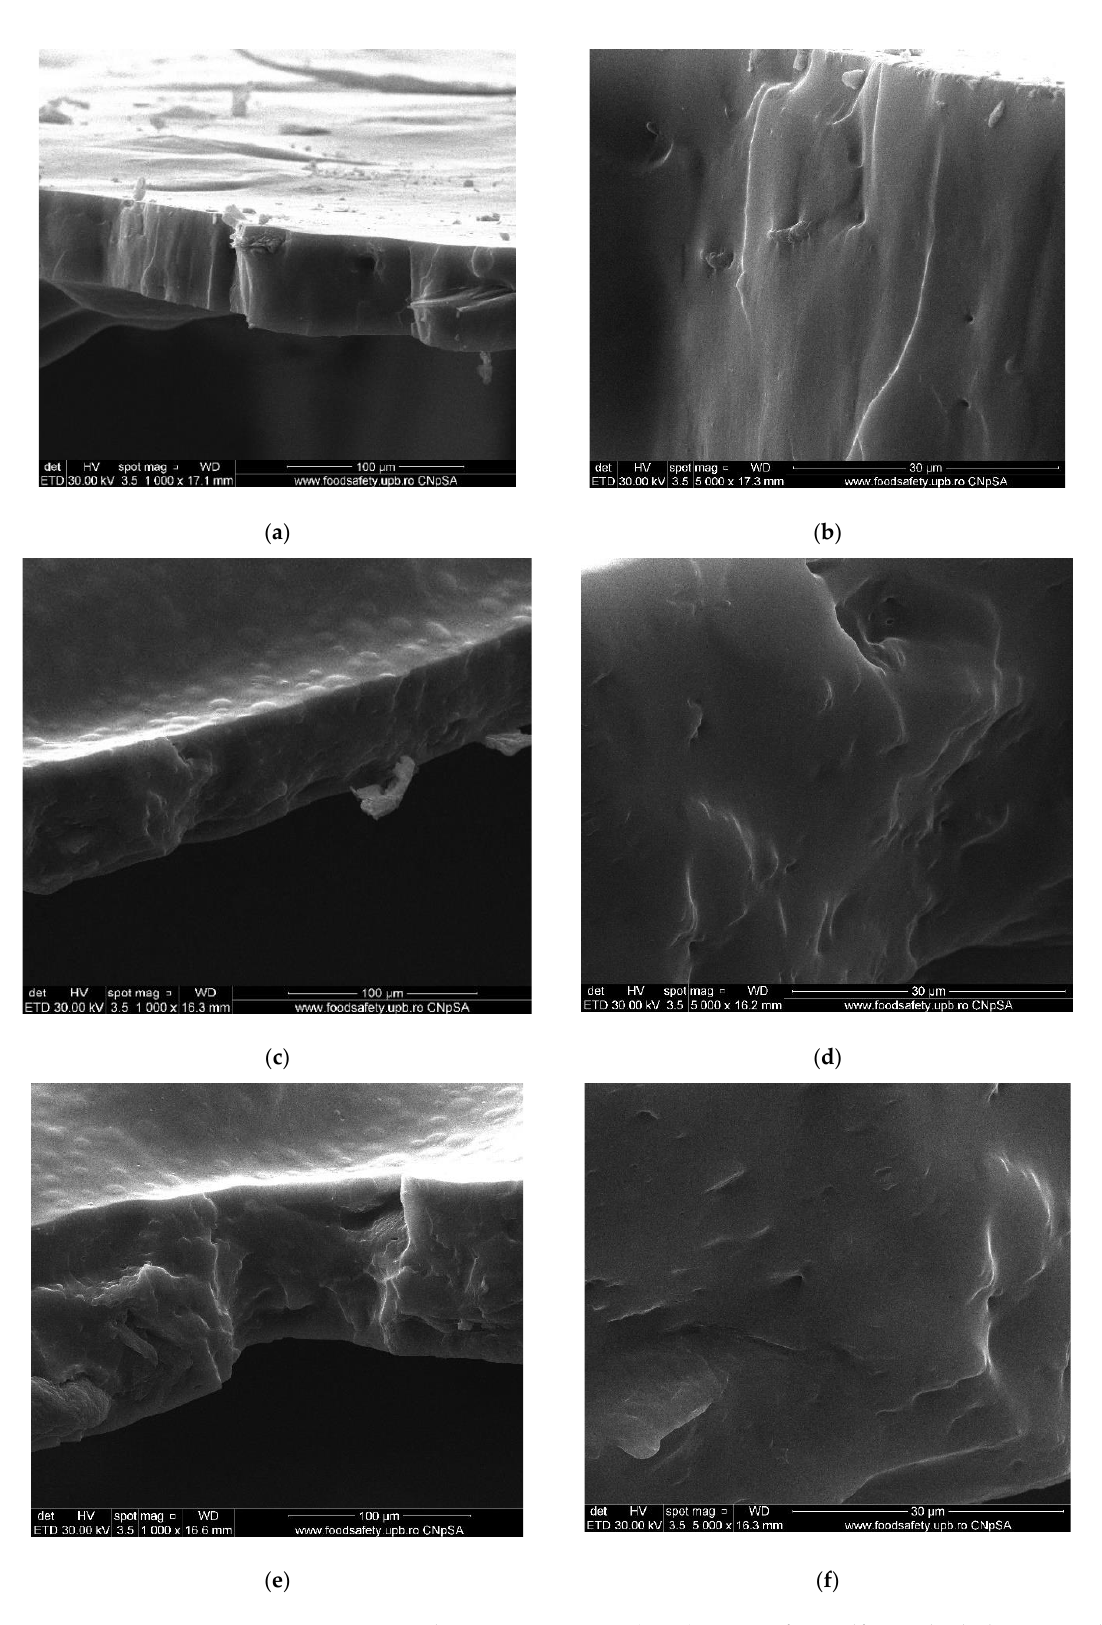
Figure 5. Scanning electron microscopy (SEM) images for: sulfonated ethylene-propylene-diene terpolymer (sEPDM) (M1)—( a , c , e ); chitosan (Chi)-sulfonated ethylene-propylene-diene terpolymer (Chi-sEPDM) (M2)—( b , d , f